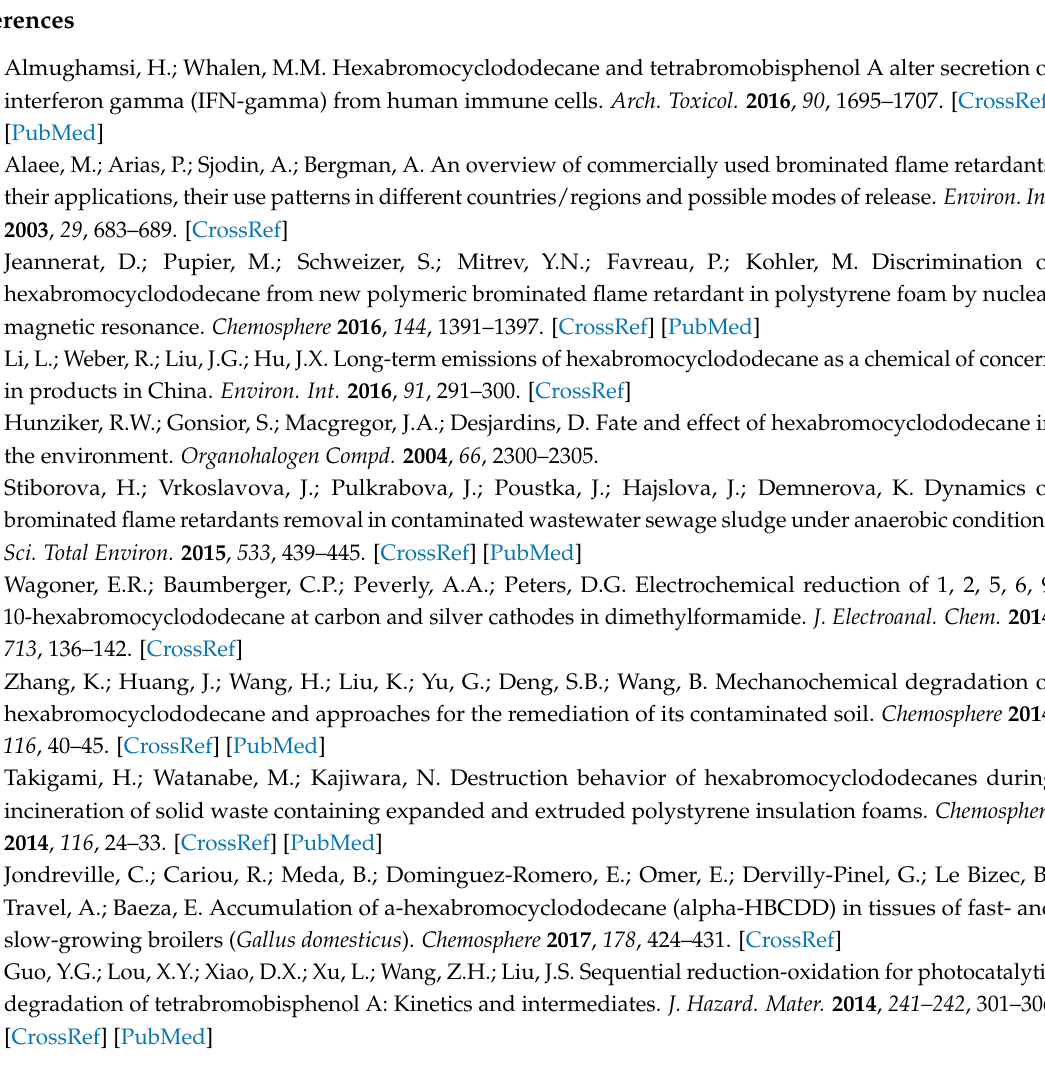
Figure S1: Photocatalysis for HBCD degradation in the UV/TiO 2 /KPS system with three time cycling uses, Figure S2: The HPLC chromatogram of